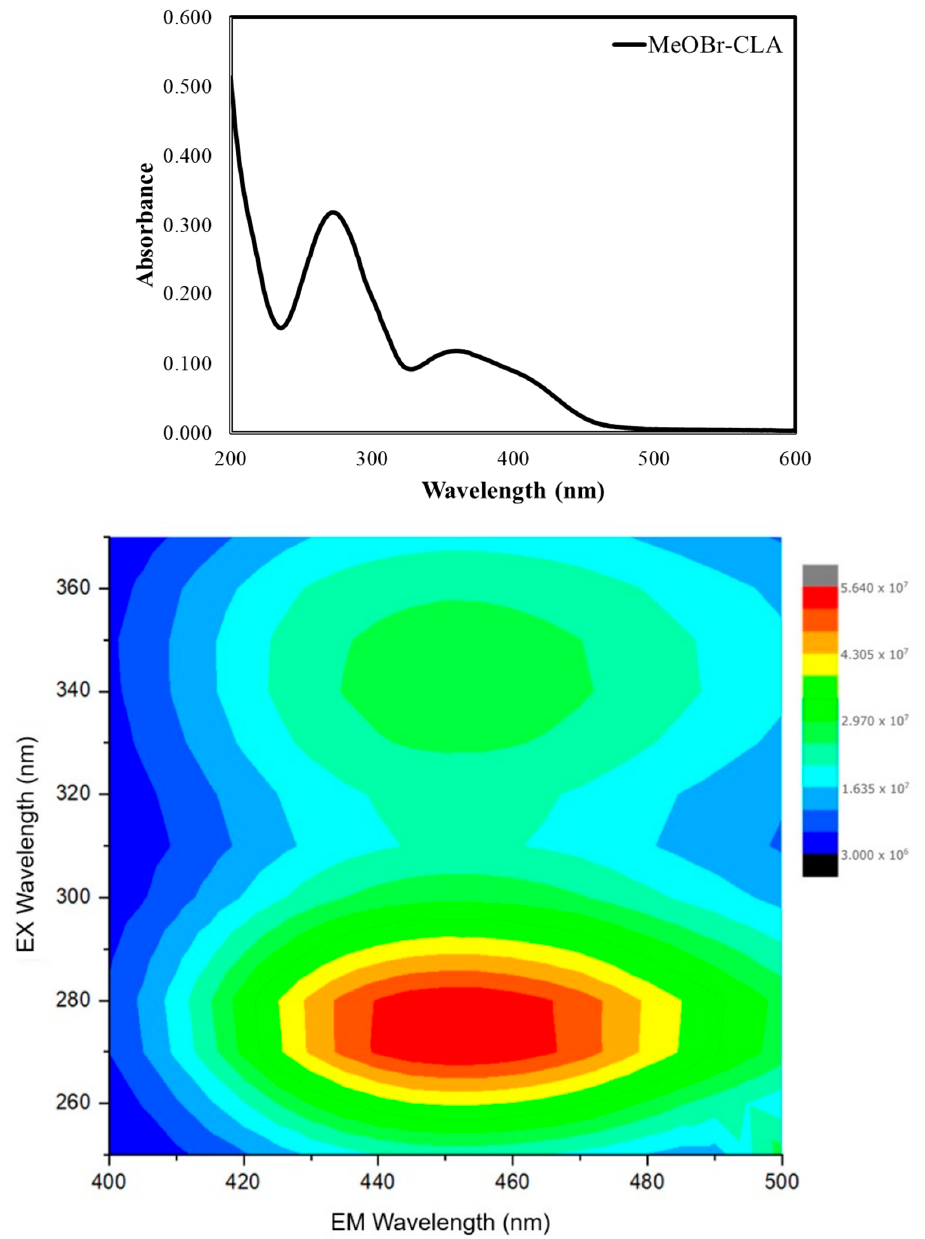
Figure 1. Absorption spectrum (top) and 2D EEM contour plot (bottom) for MeOBr-Cla (30 µ M) in aqueous solution.